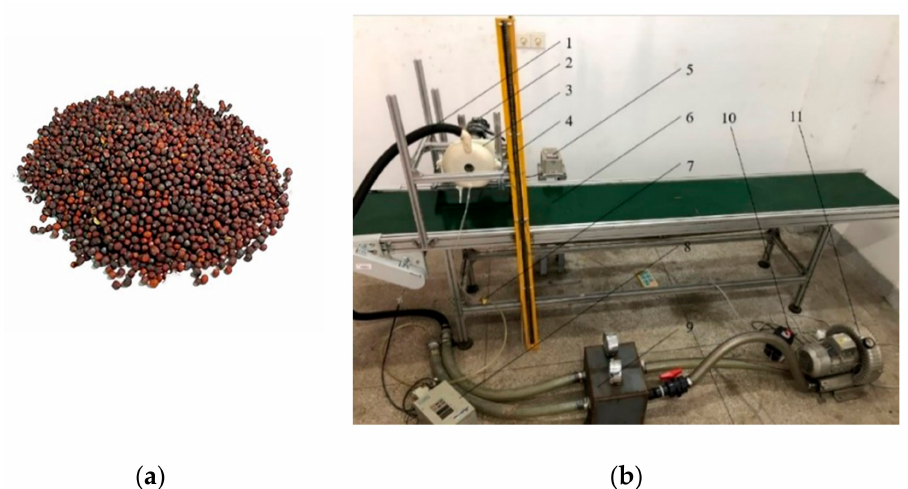
Figure 4. Test materials and seeding performance test bench. ( a ) Brassica chinensis seeds; ( b ) Test bench. 1. Vacuum tube; 2. Variable frequency motor; 3. Metering device; 4. U-Manometer; 5. Motor governor; 6. Conveyor belt; 7. Positive pressure tube; 8. Conveyor belt frequency modulator; 9. Wind pressure detection system; 10. Fan frequency regulator; 11.